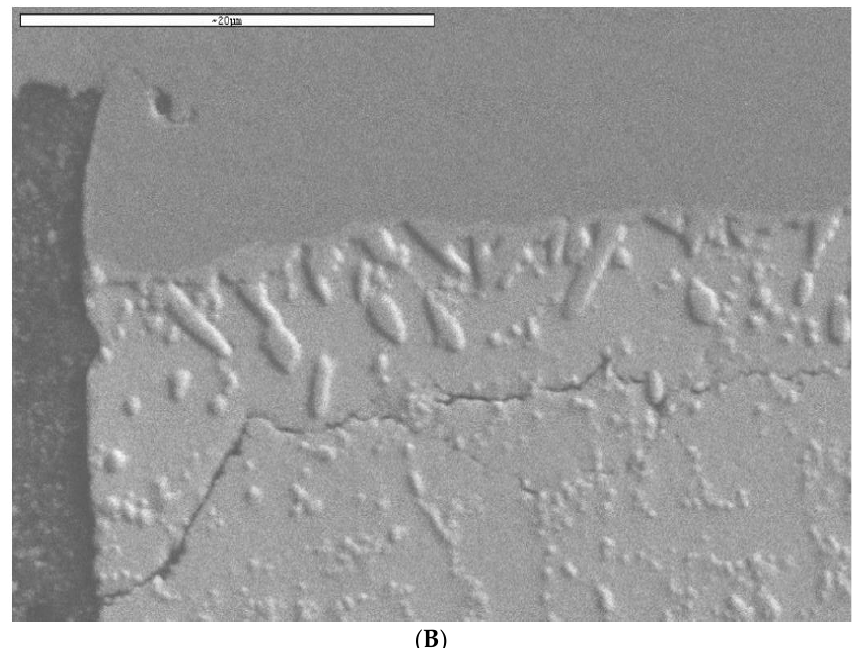
Figure 15. SEM Images of the cracked solder ball. ( A ) 2500×, 1.6 mm Board; ( B ) 2500×, 1 mm